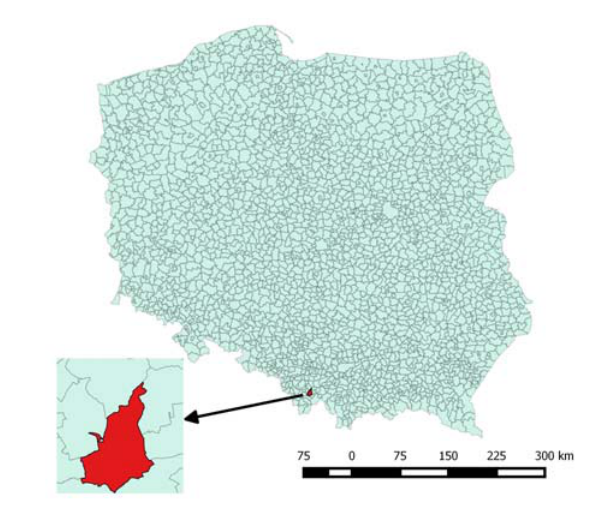
Figure 1. Location of the study